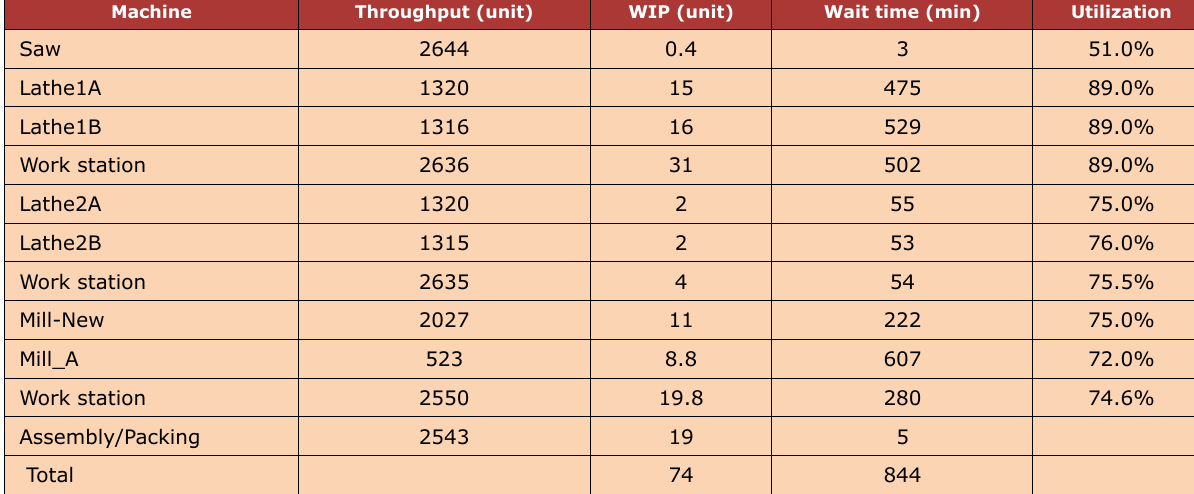
Table A1. Machine performance of one old one new mills